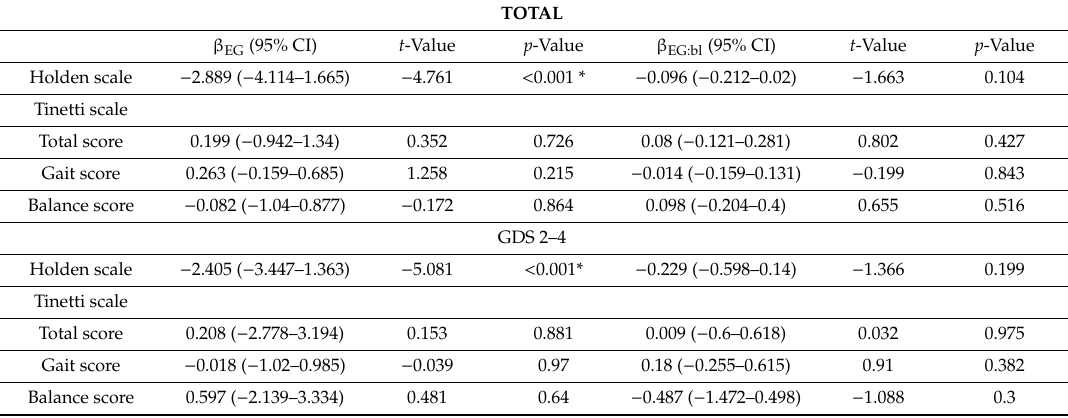
Figure 1. Linear regression model for the response variable “postintervention Holden score” as a function of the group, basal score, and their interaction. Each point represents the participant observed score, and the lines represent the fitted model and 95% confidence interval. The regression coe ffi cients for the group e ff ect are shown, with their corresponding 95% confidence interval and p -value. CG: Control group, EG: Experimental group. Table 3. Evaluation of postintervention scores on the experimental group controlling for the respective basal scores.